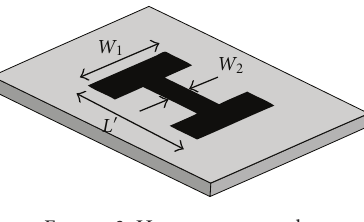
Figure 3: H antenna example.